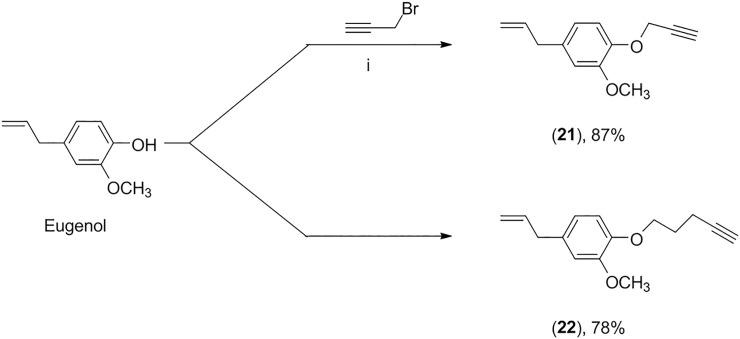
Preparation of alkylated derivatives of eugenol.i) NaOH, CH3OH, 40°C; acetonitrile, r.t; ii) NaOH, CH3OH, 40 oC; acetonitrile, 70 oC.